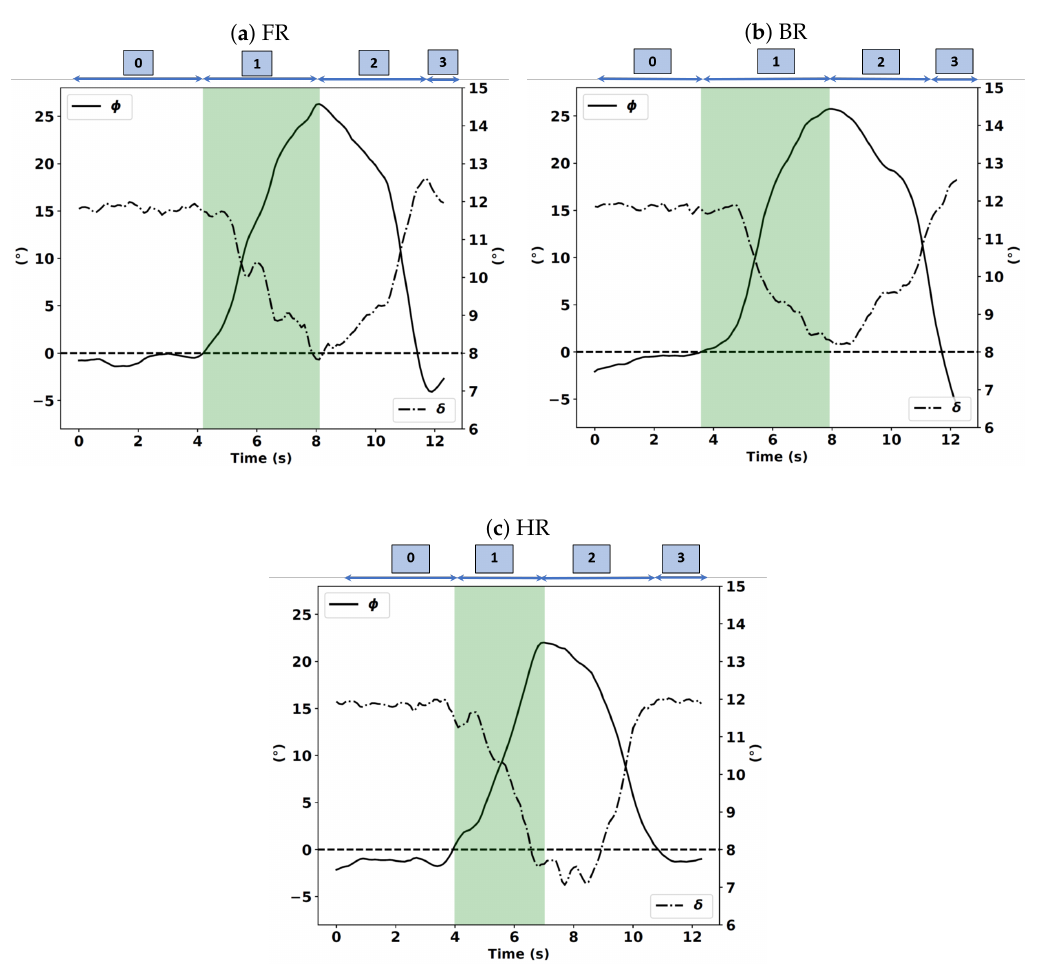
Figure 11. Handlebar steering angle δ (-.) and roll angle φ (-) expressed in degrees (°) of subject S4 for the FR, BR, and HR